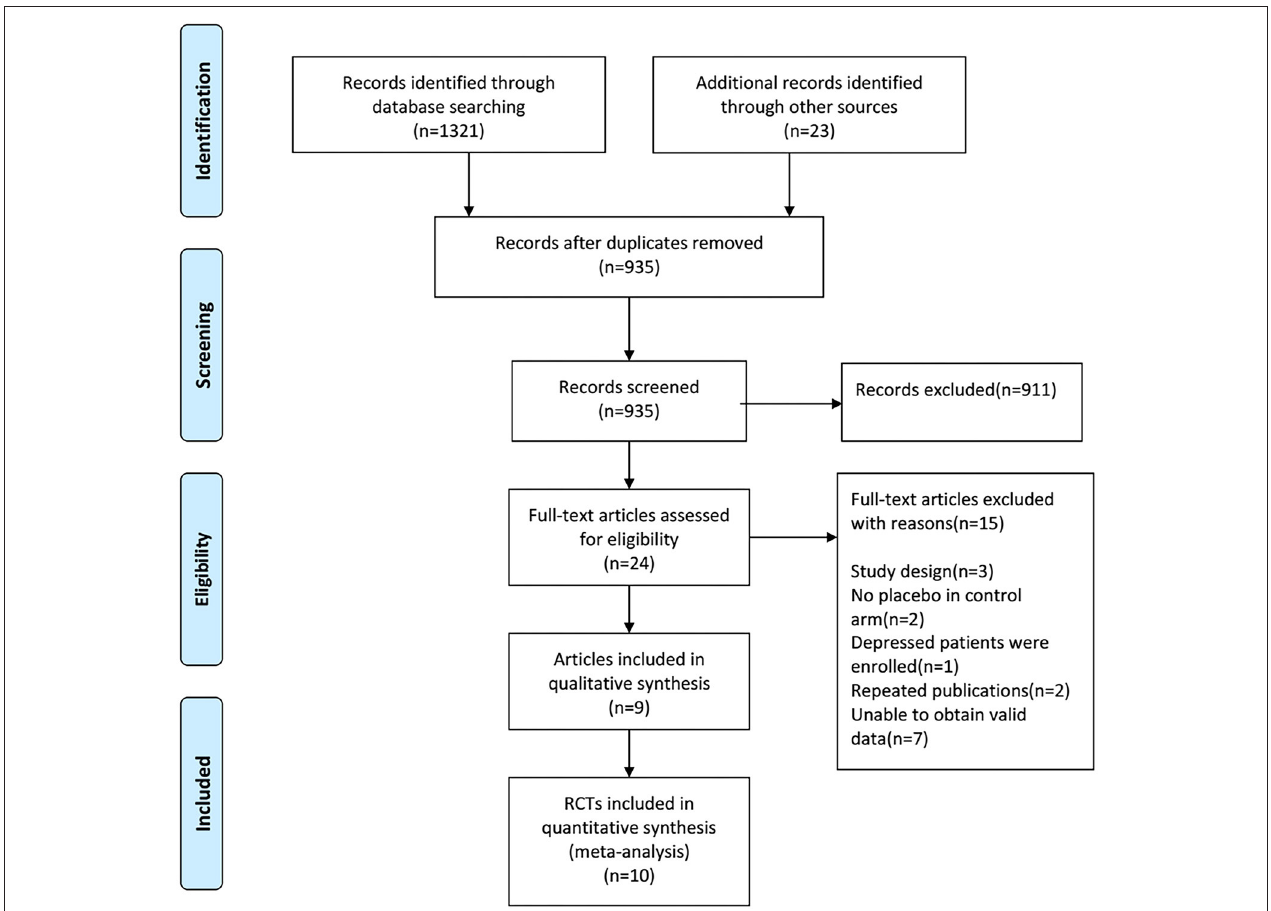
FIGURE 1 | PRISMA flow